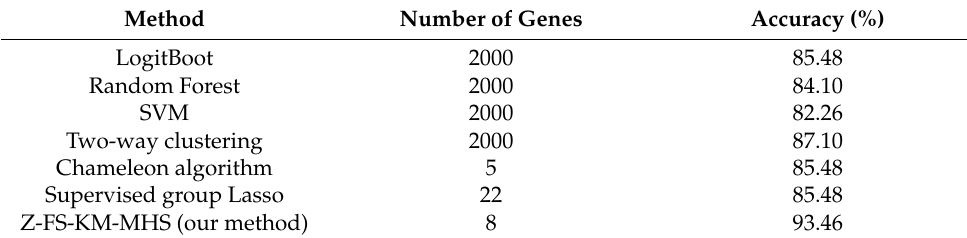
Table 3. Performance comparison of various